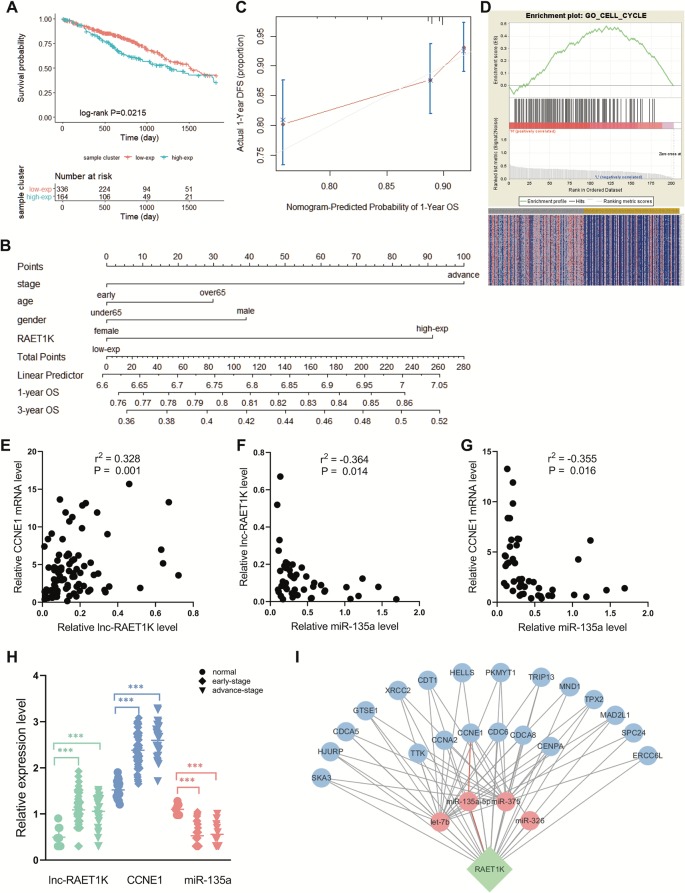
Identification of lncRNA RAET1K function and biological mechanism. (A) The Kaplan‐Meier curve of the risk score for the overall survival of RAET1K in lung adenocarcinoma (LUAD). The blue line presents the lower expression level group of RAET1K, and the red presents the higher ones. Gene enrichment plots showed gene set enrichment analysis (GSEA) between high- and low-expressed RAET1K. (B) The nomogram of clinical features and RAET1K expression level for predicting the 1- and 3-year survival with risk score. (C) calibration plot indicated this nomogram model had a predictive power for overall survival. (D) The upper enrichment plots contain value of the genes' enrichment scores and the corresponding barcode plot shows the genes position. In the bottom heatmap red represents Spearman correlations with higher expression level of RAET1K, blue represents Spearman correlations with lower expression level of RAET1K. Expression of RAET1K and CCNE1 expression level were positive related with each other (E), while RAET1K (F) and CCNE1 (G) were negatively correlated with miR-135a. (H) RAET1K and CCNE1 expression were upregulated in both early and advance stage of LUAD, while miR-135a was downregulated, ***P < 0.001. (I) Construction of ceRNA network of lncRNA-miRNA-mRNA in blue module. The green node in diamond was lncRNA RAET1K, the blue circle nodes were mRNAs, and the pink circle nodes were miRNA. The line between nodes present their relation and the red lines shown RAET1K targeted miR-135a-5p and CCNE1.